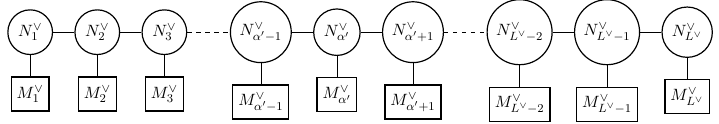
Figure 7 . The linear quiver which is mirror dual to the generic linear quiver in figure 6. The total number of gauge nodes is L ∨